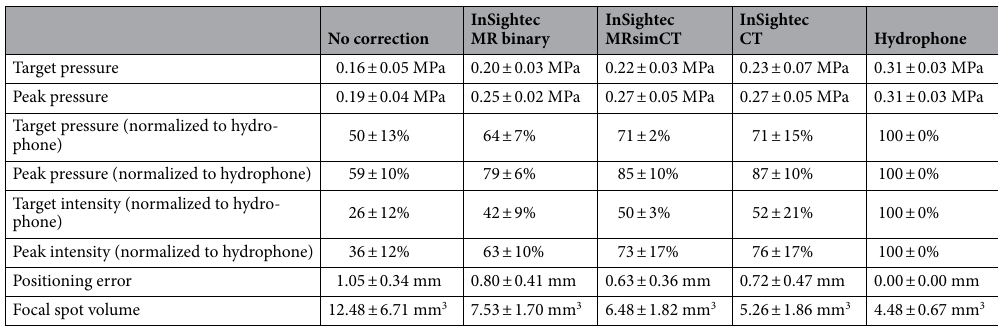
Table 1. Summary of results for the phase corrected focal spots (target at the geometric focus).